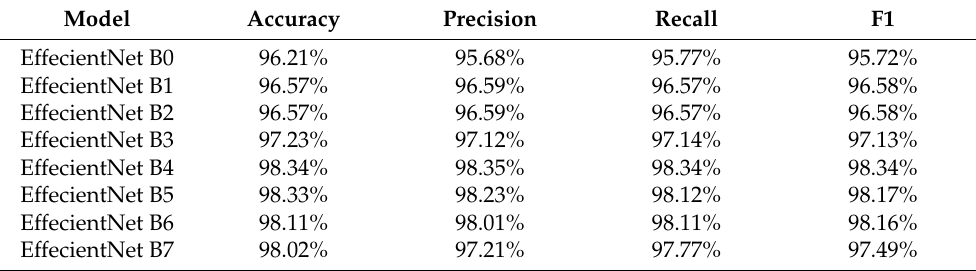
Table 3. Results for pavement defect detection on augmented dataset.